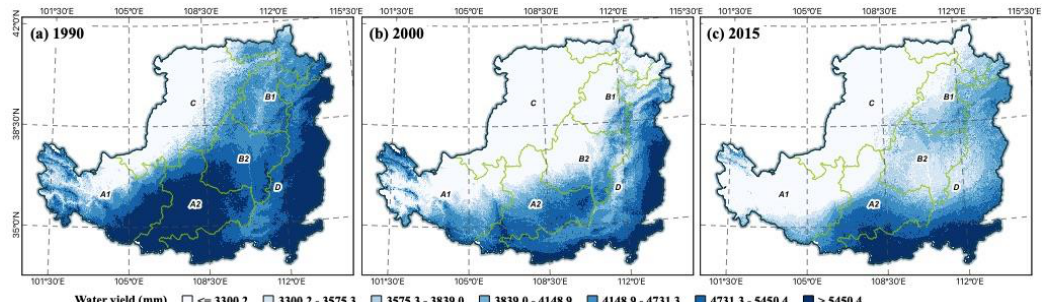
Figure 4. Water yield change in the LP, 1990 ( a ), 2000 ( b ), 2015 ( c ).